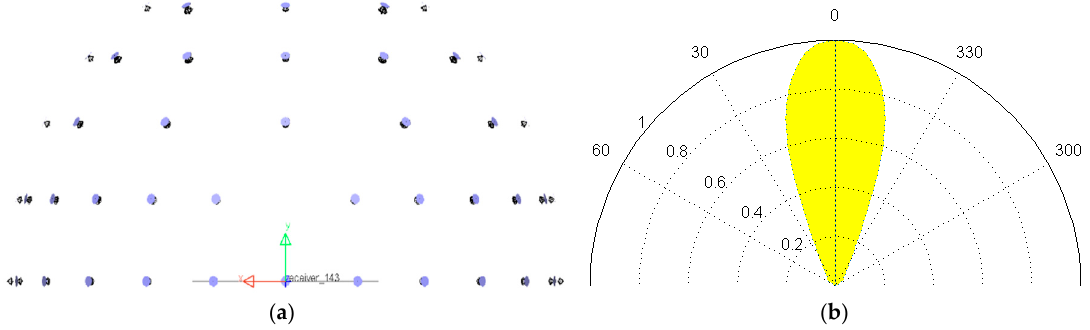
Figure 4. The model built by LightTools. ( a ) The spatial distribution of lamps in the hemispherical lamp array, and ( b ) the normalized intensity distributed by the zenith of one lamp. Table 6. The parameters of the LightTools model.